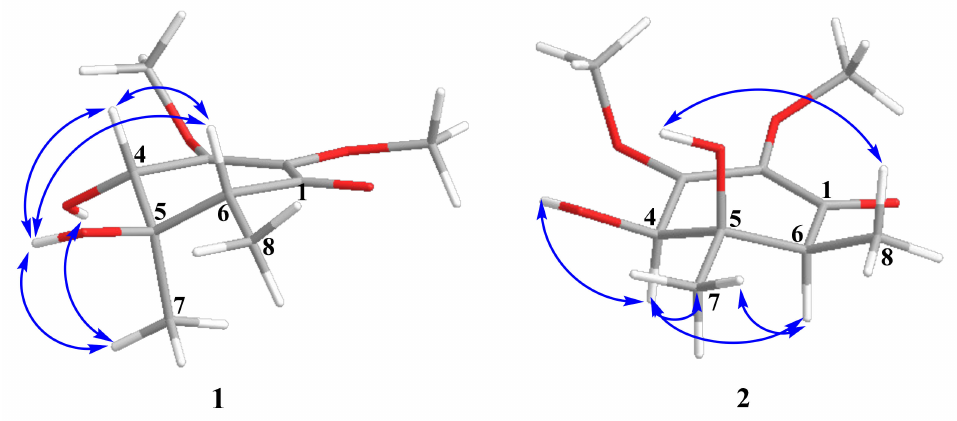
Figure 3. Key ROESY correlations in compounds 1 and 2 .